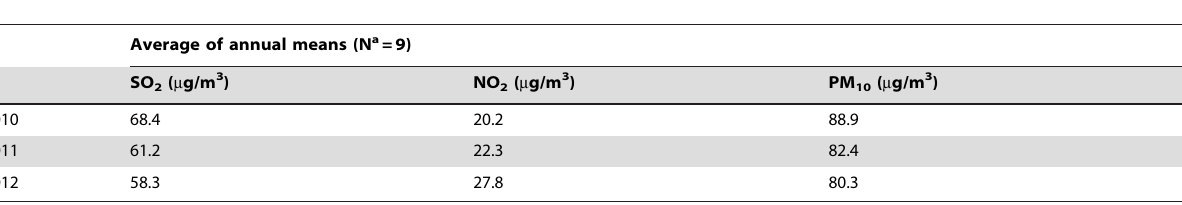
Table 6. Annual means of outdoor exposures measured at monitoring stations.